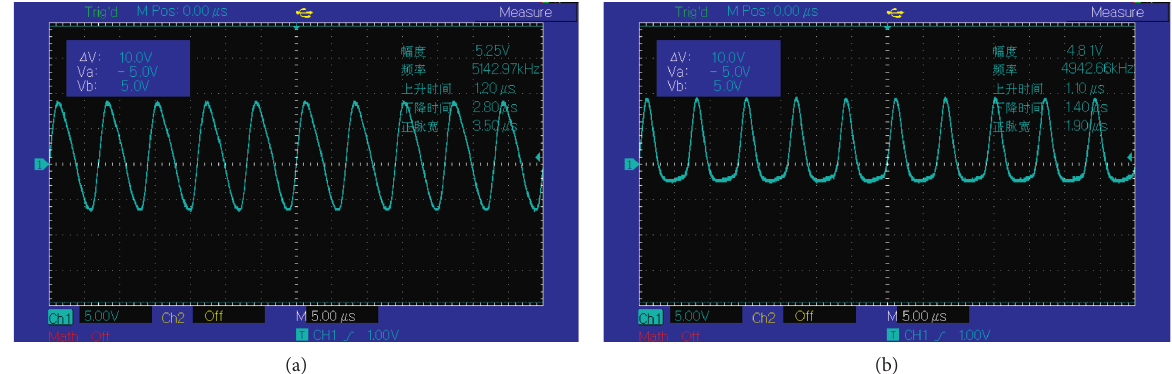
Figure 8: Experimental waveform diagrams. (a) Voltage waveform of primary coil supply. (b) Induced voltage waveform of secondary coil.